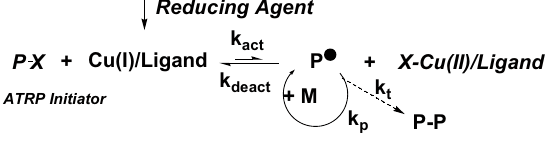
Scheme 6. Proposed mechanism for AGET ATRP initiation. All ingredients present in the initial system are highlighted in